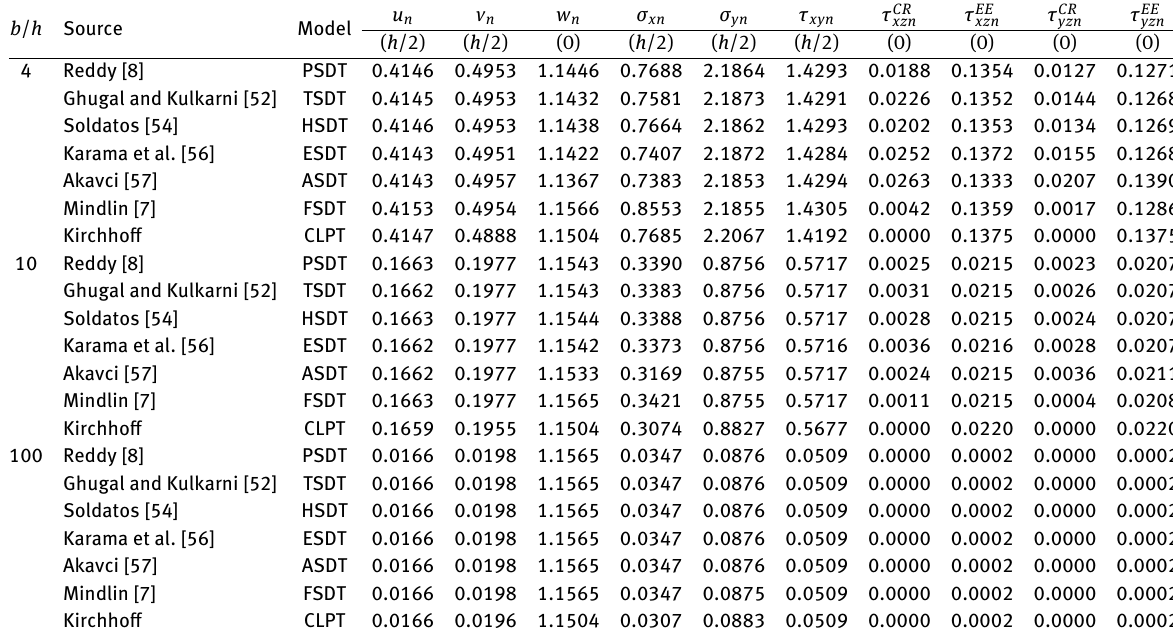
Table 2: Comparison of thermal displacement and stresses of simply supported square ( b = a ) two layered (0 ∘ /90 ∘ ) anti-symmetric lami- nated composite plate subjected to sinusoidally distributed linear thermal